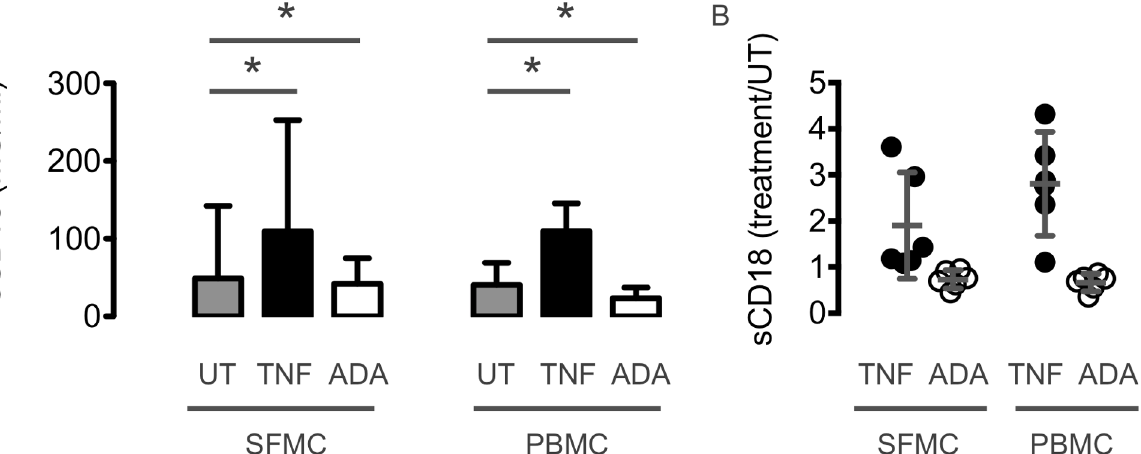
Fig 3. In vitro CD18 shedding from SFMC and PBMC from 6 chronic RA patients with disease flare after stimulation with TNF α or inhibition with adalimumab (ADA). The concentration of sCD18 from RA SFMC and PBMC was increased by TNF α and decreased by adalimumab compared with untreated cultures (UT). n = 6. (A) The concentration of sCD18 measured as mU/ml. (B) The relative change in sCD18 compared with untreated cultures. Boxes and error bars indicate median and interquartile range. Data were analyzed using non-parametric statistics. * P <